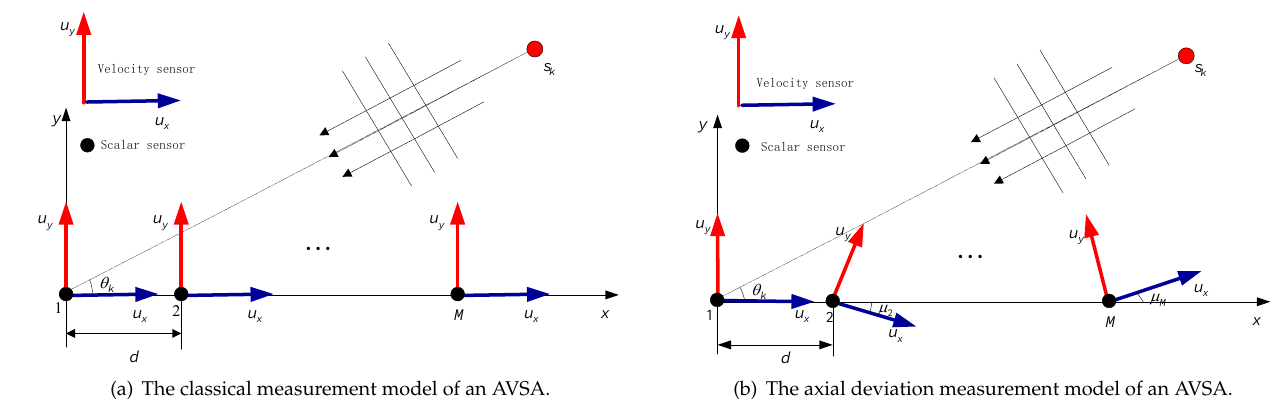
(b) The axial deviation measurement model of an AVSA. Figure 1. The two AVS ULA measurement